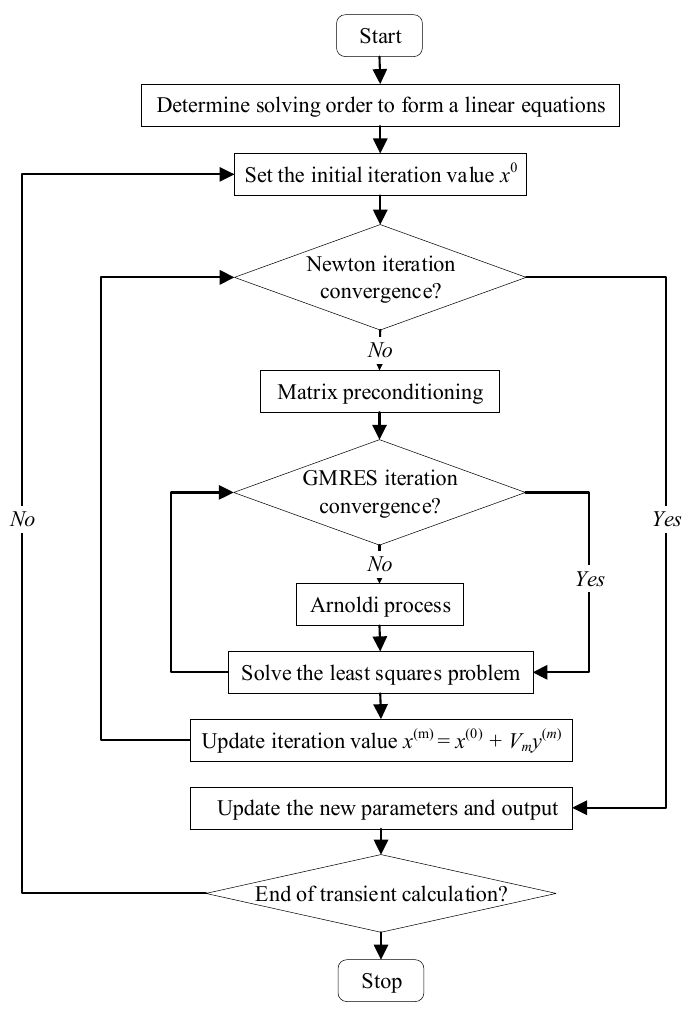
Figure 3. The computational flow chart of the JFNK algorithm.